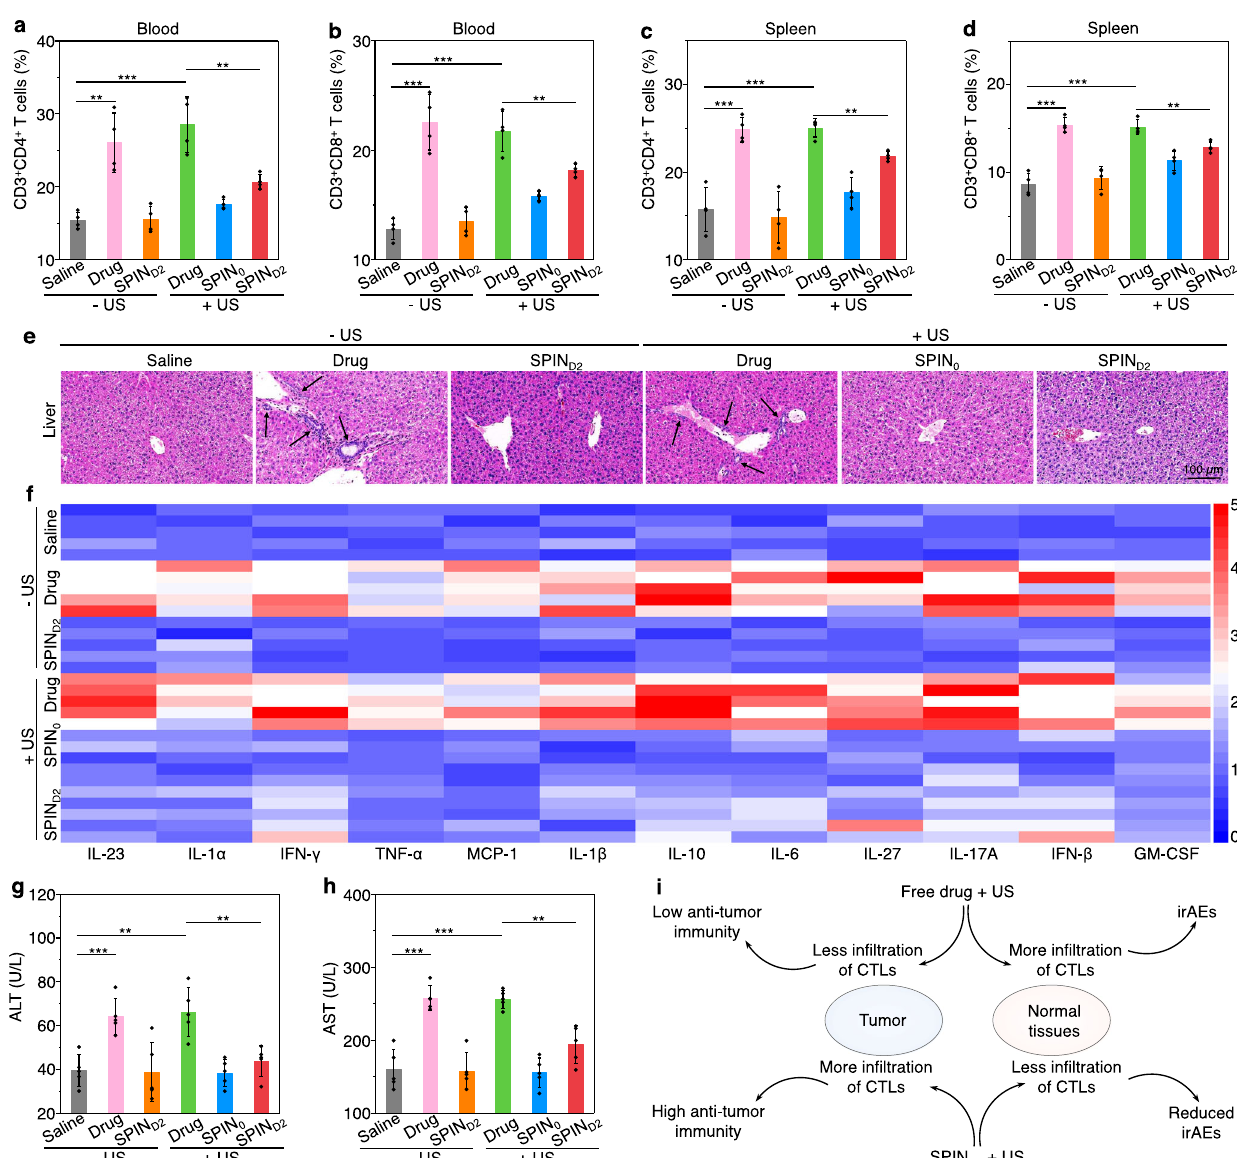
Fig. 6 Preliminary evaluation of minimized irAEs for SPIN D2 -mediated sono-immunotherapy. a , b Flow cytometry analysis of percentages of CD3 + CD4 + Th cells ( a ), and CD3 + CD8 + CTLs ( b ) in blood of mice ( n = 4) at 30 day after systemic administrations of saline, SPIN 0 , SPIN D2 (0.2mL, 1.2mg/mL) or free- drug mixture (8mg/kg body weight for NLG919 and aPD-L1) with or without US irradiation (1.0MHz, 1.2W/cm 2 , 50% duty cycle, 10min). Saline – US versus drug − US: P = 0.0023; saline − US versus drug + US: P = 0.0006; drug + US versus SPIN D2 + US: P = 0.0071 for CD3 + CD4 + Th cells ( a ); saline − US versus drug − US: P = 0.0004; saline − US versus drug + US: P = 0.0001; drug + US versus SPIN D2 + US: P = 0.0093 for CD3 + CD8 + CTLs ( b ). c , d Flow cytometry analysis of percentages of CD3 + CD4 + Th cells ( c ), and CD3 + CD8 + CTLs ( d ) in spleen of mice ( n = 4) after different treatments for 30 days. Saline − US versus drug − US: P = 0.0008; saline − US versus drug + US: P = 0.0005; drug + US versus SPIN D2 + US: P = 0.0015 for CD3 + CD4 + Th cells ( c ); saline − US versus drug − US: P = 0.0001; saline − US versus drug + US: P = 0.0002; drug + US versus SPIN D2 + US: P = 0.0049 for CD3 + CD8 + CTLs ( d ). e Representative H&E staining images of liver after 30 days of treatments in different groups (white arrows indicate the in fi ltrated lymphocytes). The experiments were repeated independently three times with similar results. f Heatmap to show relative fold of cytokine levels in serum of mice after different treatments for 30 days relative to those in saline control group. g , h Serum levels of ALT ( g ) and AST ( h ) in mice ( n = 5) after different treatments for 30 days. Saline − US versus drug − US: P = 0.0010; saline − US versus drug + US: P = 0.0020; drug + US versus SPIN D2 + US: P = 0.0054 for ALT ( g ); saline − US versus drug − US: P = 0.0001; saline − US versus drug + US: P <0.0001; drug + US versus SPIN D2 + US: P = 0.0013 for AST ( h ). i Summary comparison of the antitumor immunity and irAEs between SPIN D2 -mediated sono-immunotherapy and free-drug treatment. Data are presented as mean values±SD. Statistical signi fi cance was calculated via two-tailed Student ’ s t test; ** P < 0.01, *** P < 0.001. Source data are provided as a Source Data fi